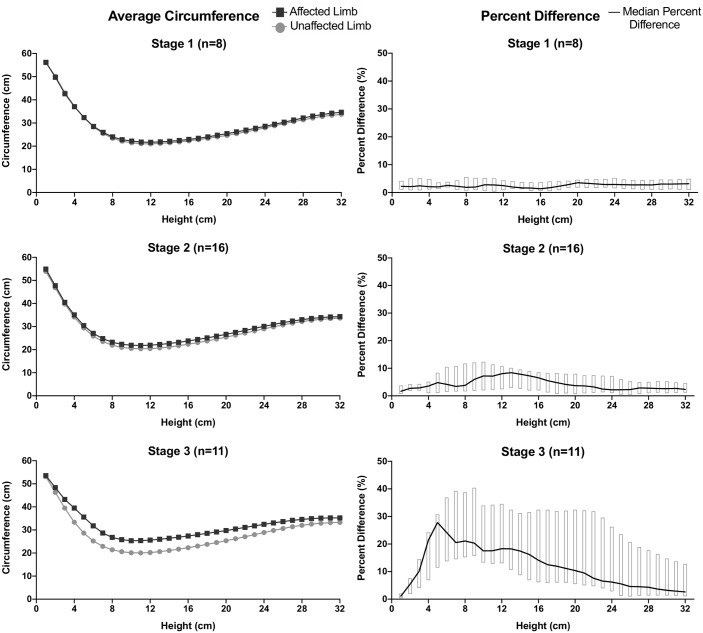
Location of lymphedema among participants with one affected and one unaffected limb.Panels on the left indicate the mean limb circumference of affected limbs (black squares) and unaffected (stage 0) limbs (gray circles) for the group of patients with unilateral lymphedema of the stage indicated. The difference between the circumferences of the affected limb minus the circumferences of the unaffected limb (stage 0) is shown in the right hand panels, Panel titles indicate the number of analyzed limbs in parentheses.